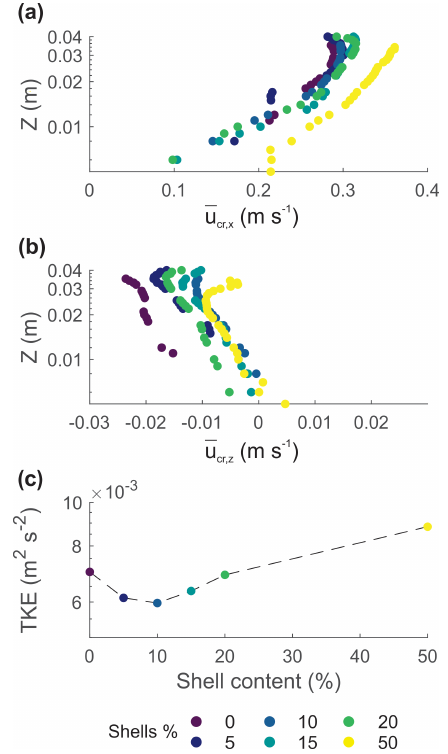
Figure 5. Time-averaged near-bed velocity profiles showing the (a) x and (b) z direction of the constant flow experimental runs as well as the (c) peak TKE values plotted against shell content. Note that the profiles are time-averaged, as indicated by the over- bars, over the entire duration of each experimental run.